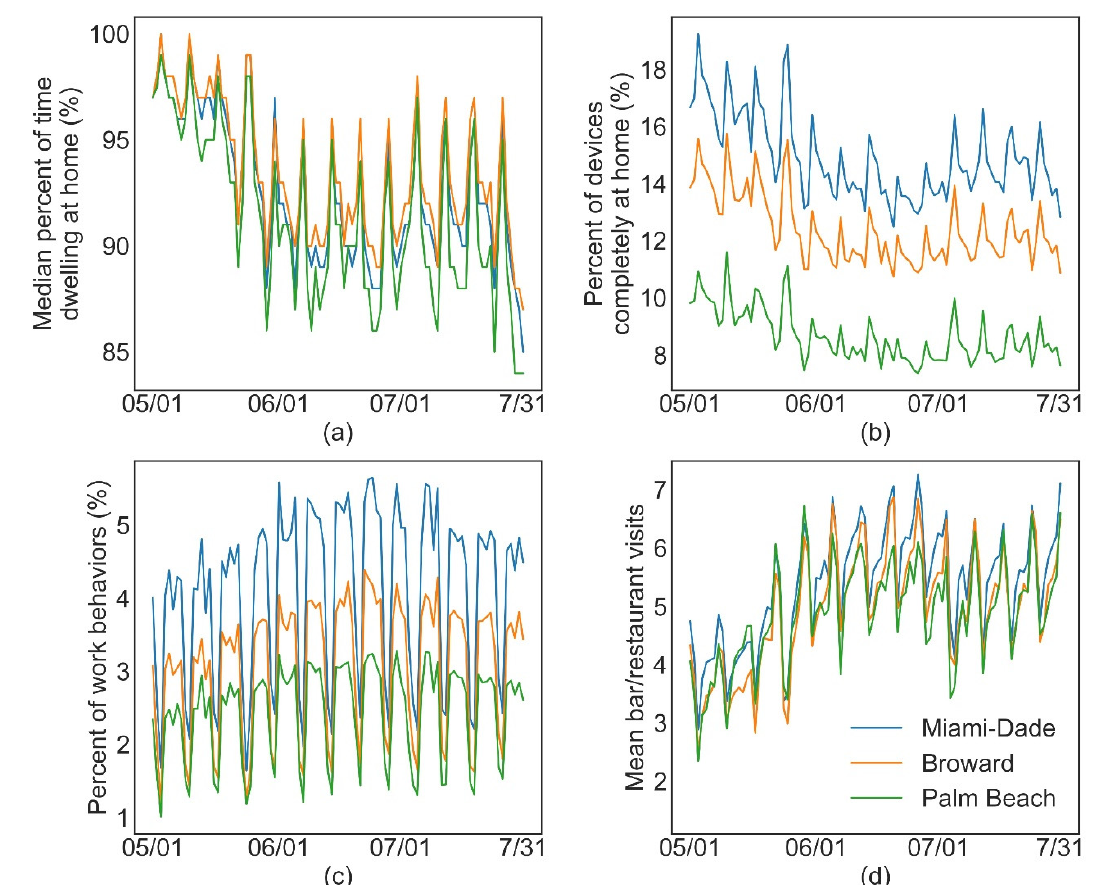
Figure 4. Mobility-related behaviors during 05/01–07/31/2020, including ( a ) median percent of time dwelling at home, ( b ) percent of devices completely at home, ( c ) percent of both full-time and part-time work behaviors (i.e., devices spending over three hours away from home), and ( d ) mean bar and restaurant visits.